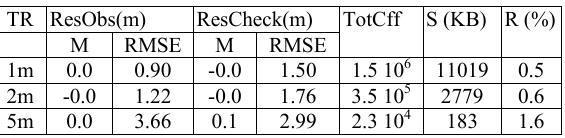
Table 7. Analysis of MBA. TR: interpolated dataset. ResObs, ResCheck: MBA statistics of the residuals on the used observations and the check points. M: mean. RMSE: root mean square error. TotCff: total number of coefficients of MBA. S: MBA storage size. R: ratio between the storage requirements of our algorithm and